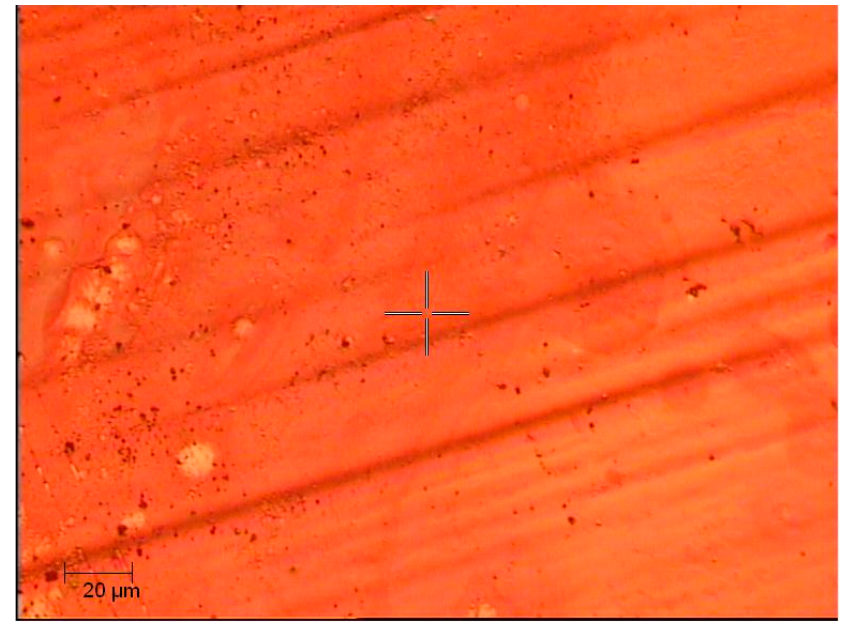
Figure 4. Photomicrograph of the sample with thickness of 418 nm at 200× magnification.